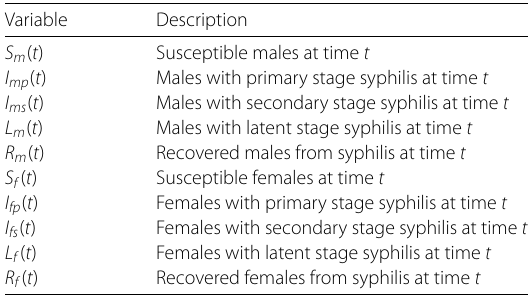
Table 1 Syphilis model variables